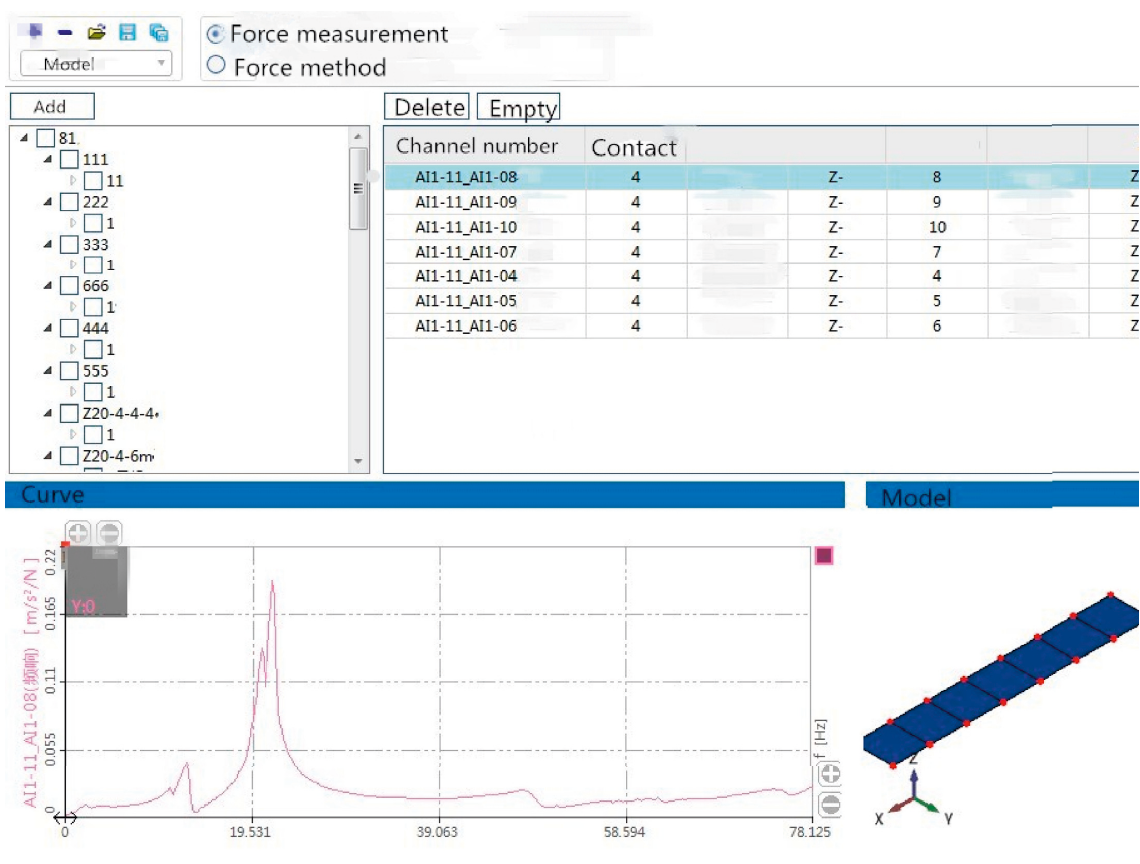
Figure 10: Force measurement data import.